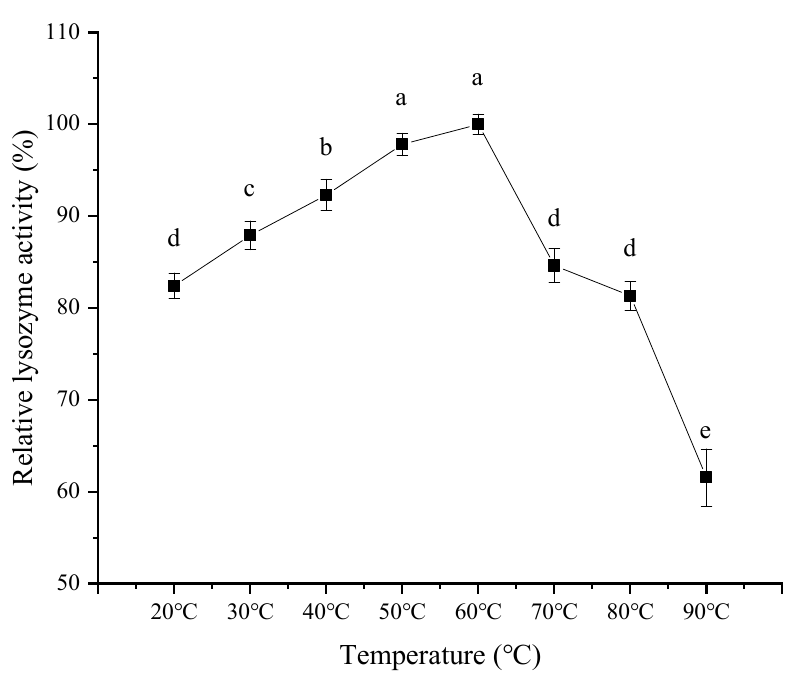
Figure 9. Effect of temperature on activity of lysozyme from SDEW.